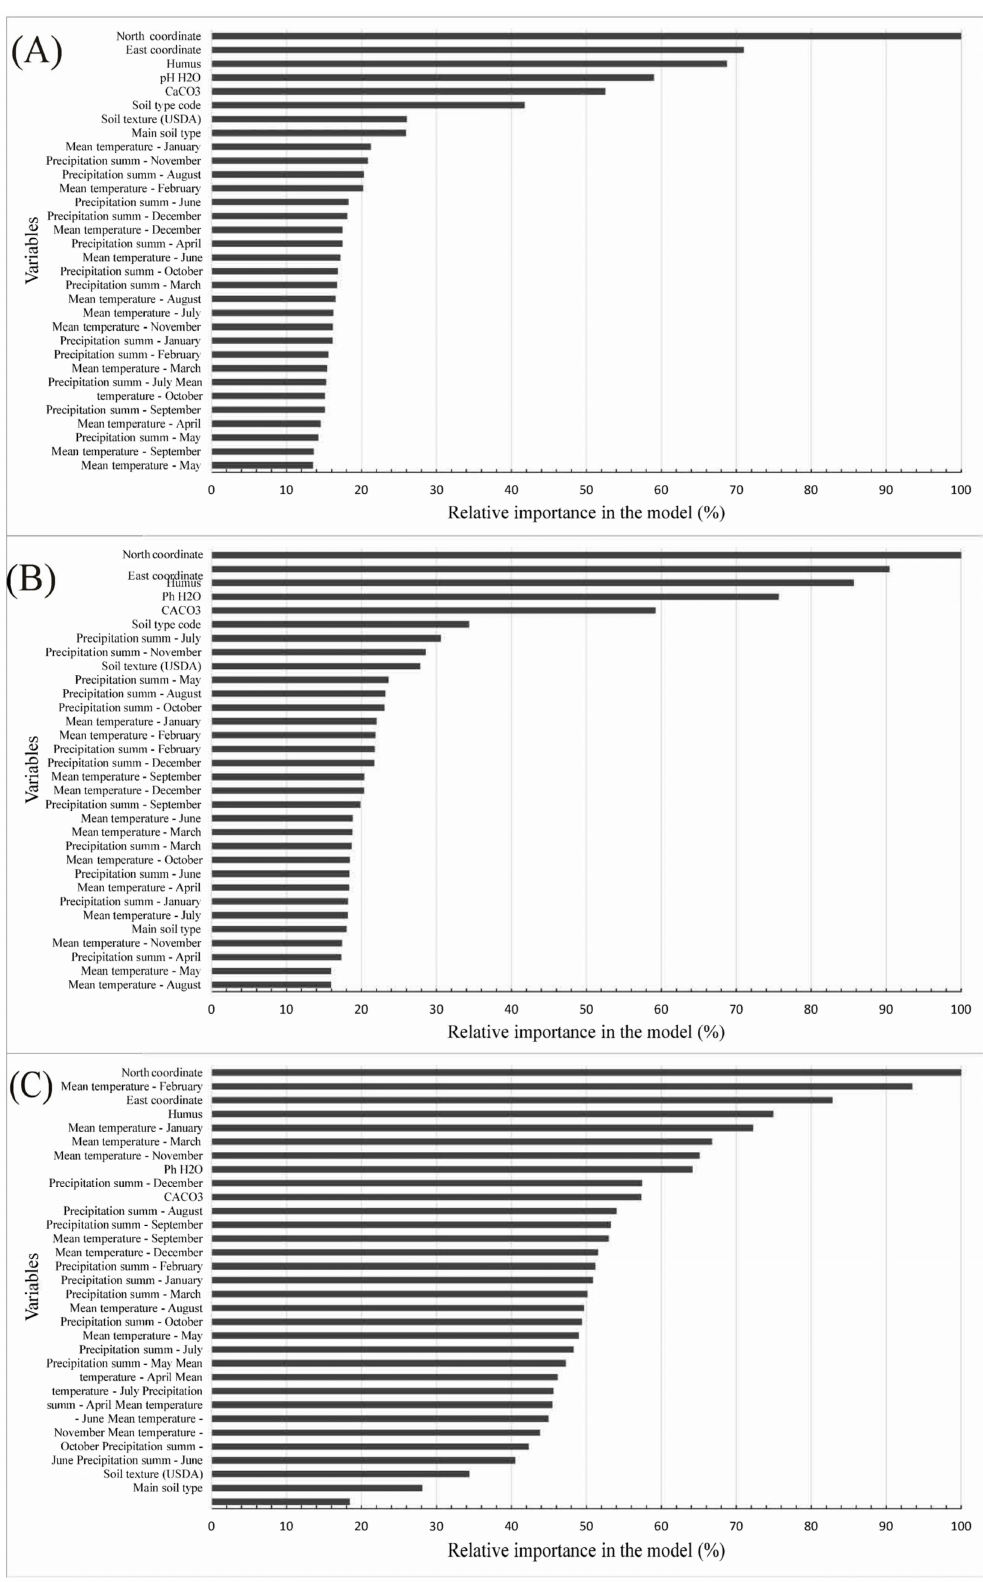
Figure 6. Overall importance of explanatory variables in predicting wheat ( A ), maize ( B ) and sunflower ( C ) biomass